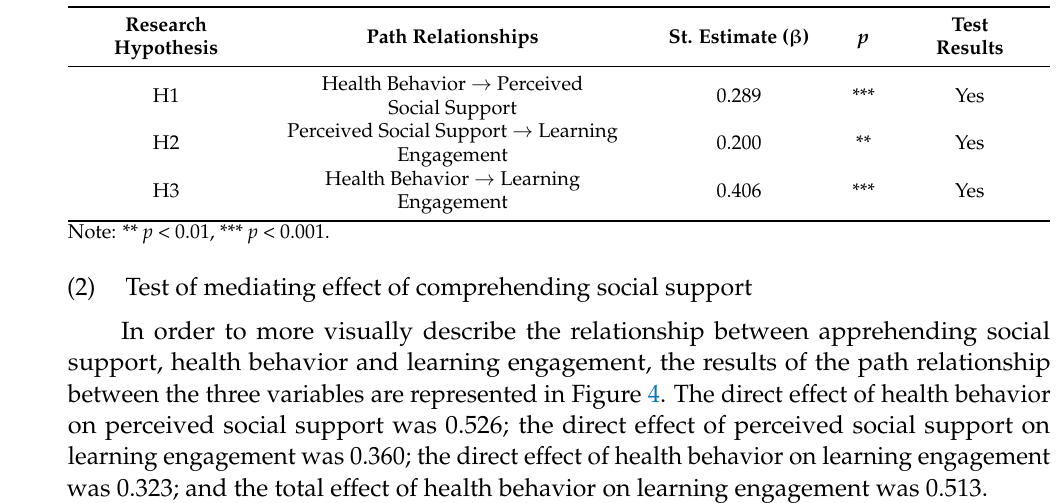
Table 7. Path hypothesis tests among the